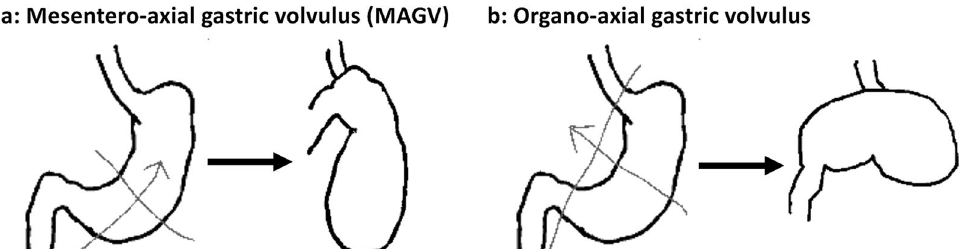
Fig. 7 a Mesentero-axial GV refers to rotation of the stomach along the short axis. b Organo-axial GV refers to rotation along the longitudinal